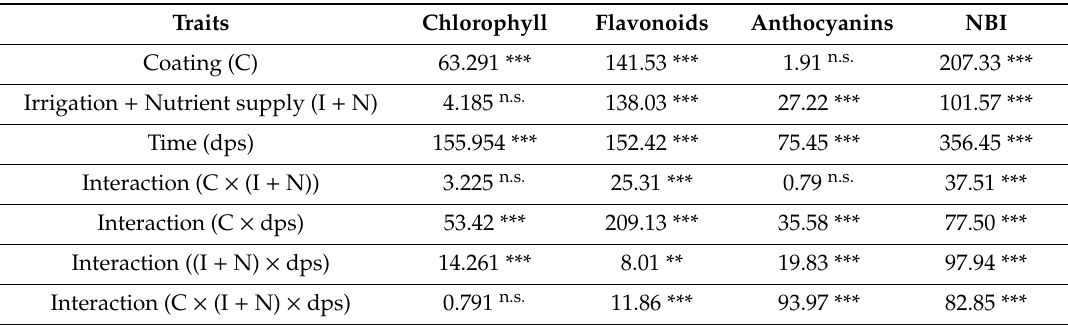
Table 5. Results of three-factor ANOVA for chlorophyll, flavonoids, anthocyanins, and nitrogen balance index (NBI) in coated control plants and plants coated with thyme oil grown under moderate, short-term and long-term severe water / nutrient stress.